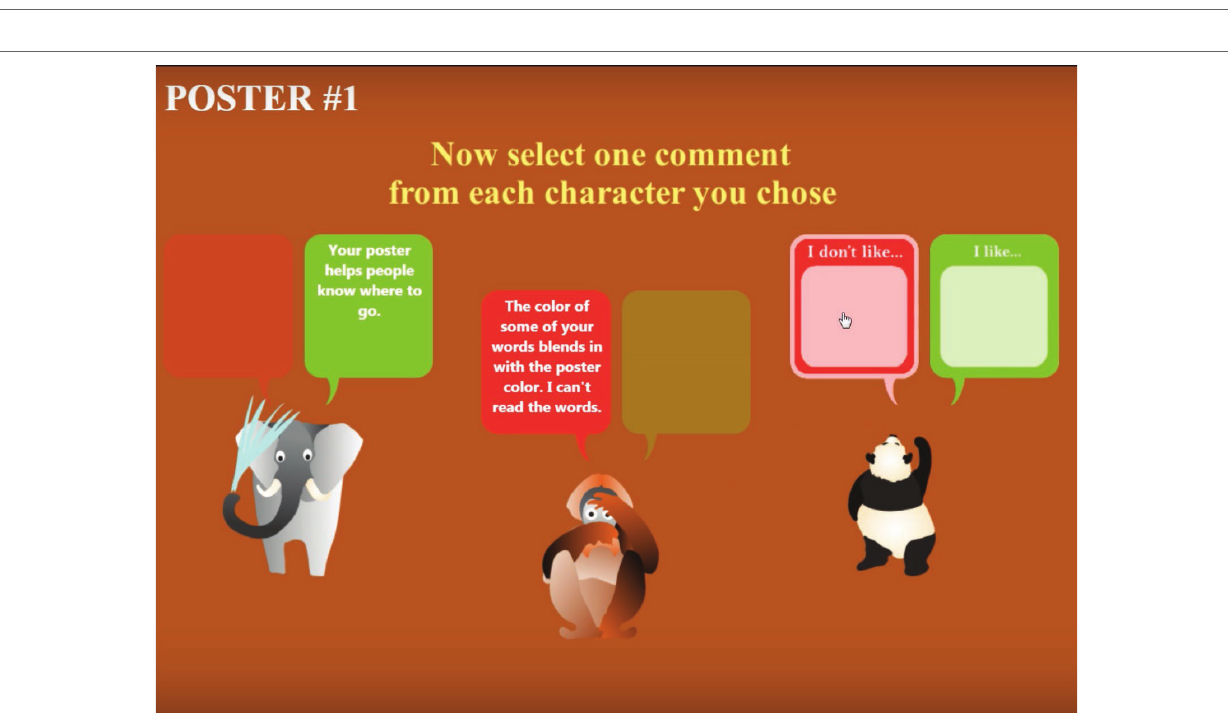
FIGURE 1 | In Posterlet, players can design posters using pre-determined text and images.